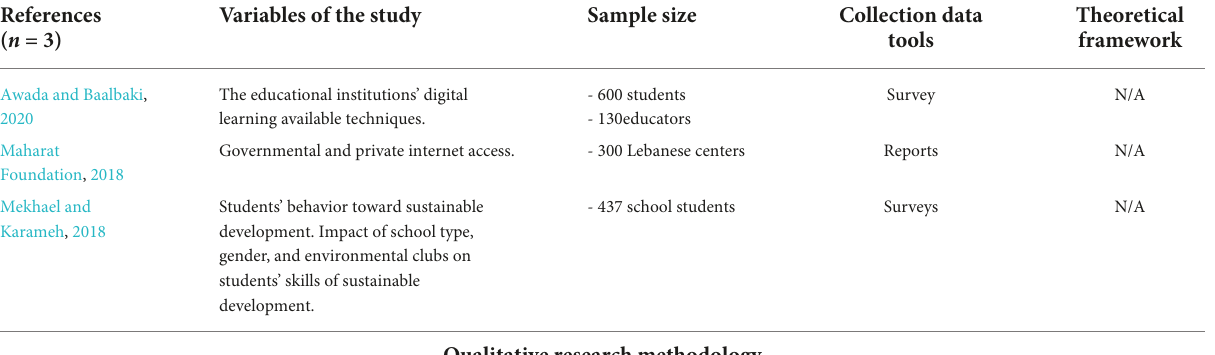
TABLE 1 Review on studies conducted in the Lebanese context about education, environment, and digital